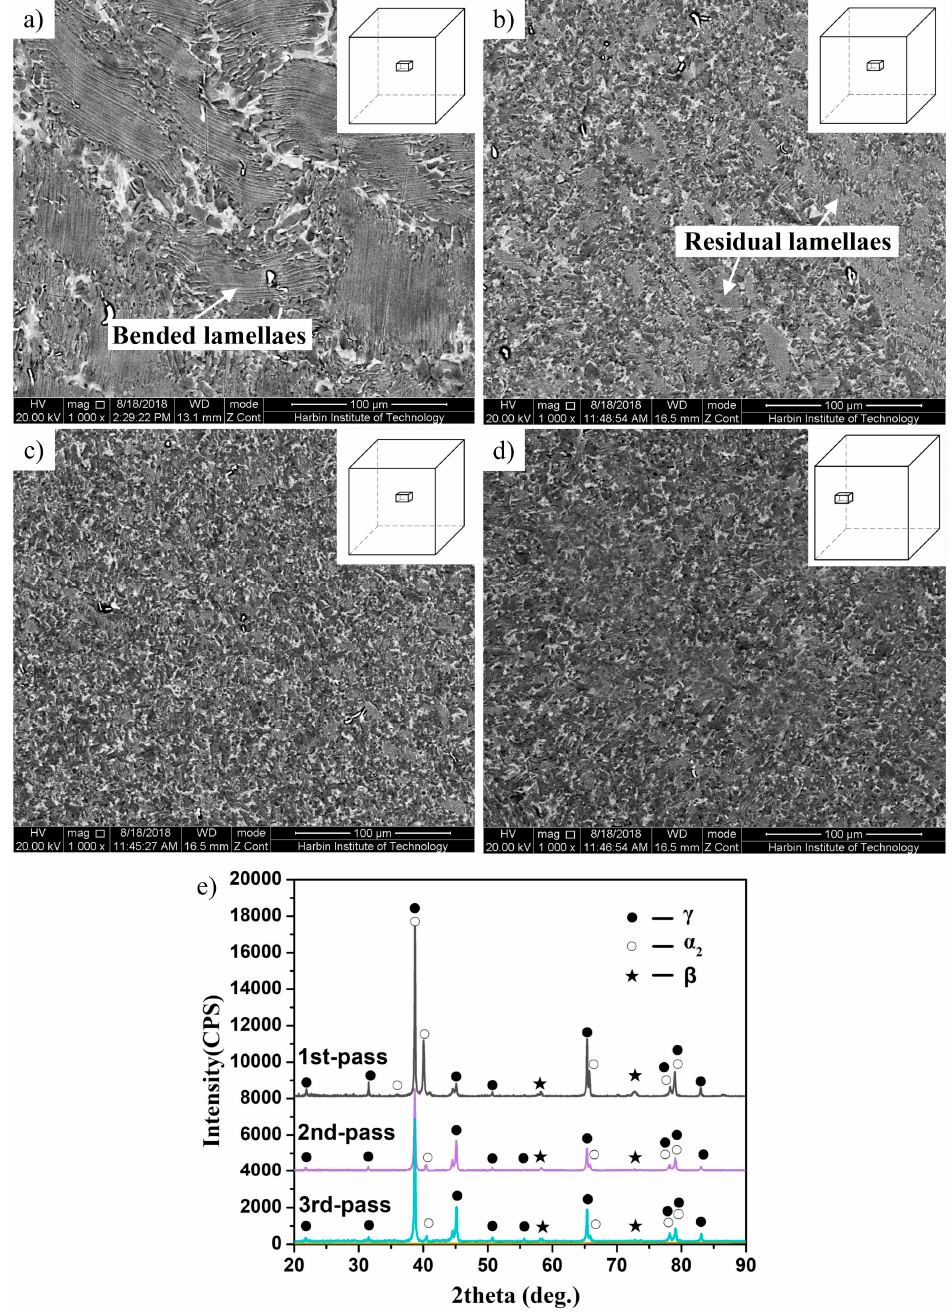
Figure 5. E ff ect of forging pass (30% reduction per pass) on microstructures of Ti-43Al-2Cr-1.5Mn-0.2Y alloy. ( a ) One pass / center area, ( b ) two passes / center area, ( c ) three passes / center area, and ( d ) three passes / bulging area. ( e ) X-ray di ff raction (XRD) patterns after di ff erent forging